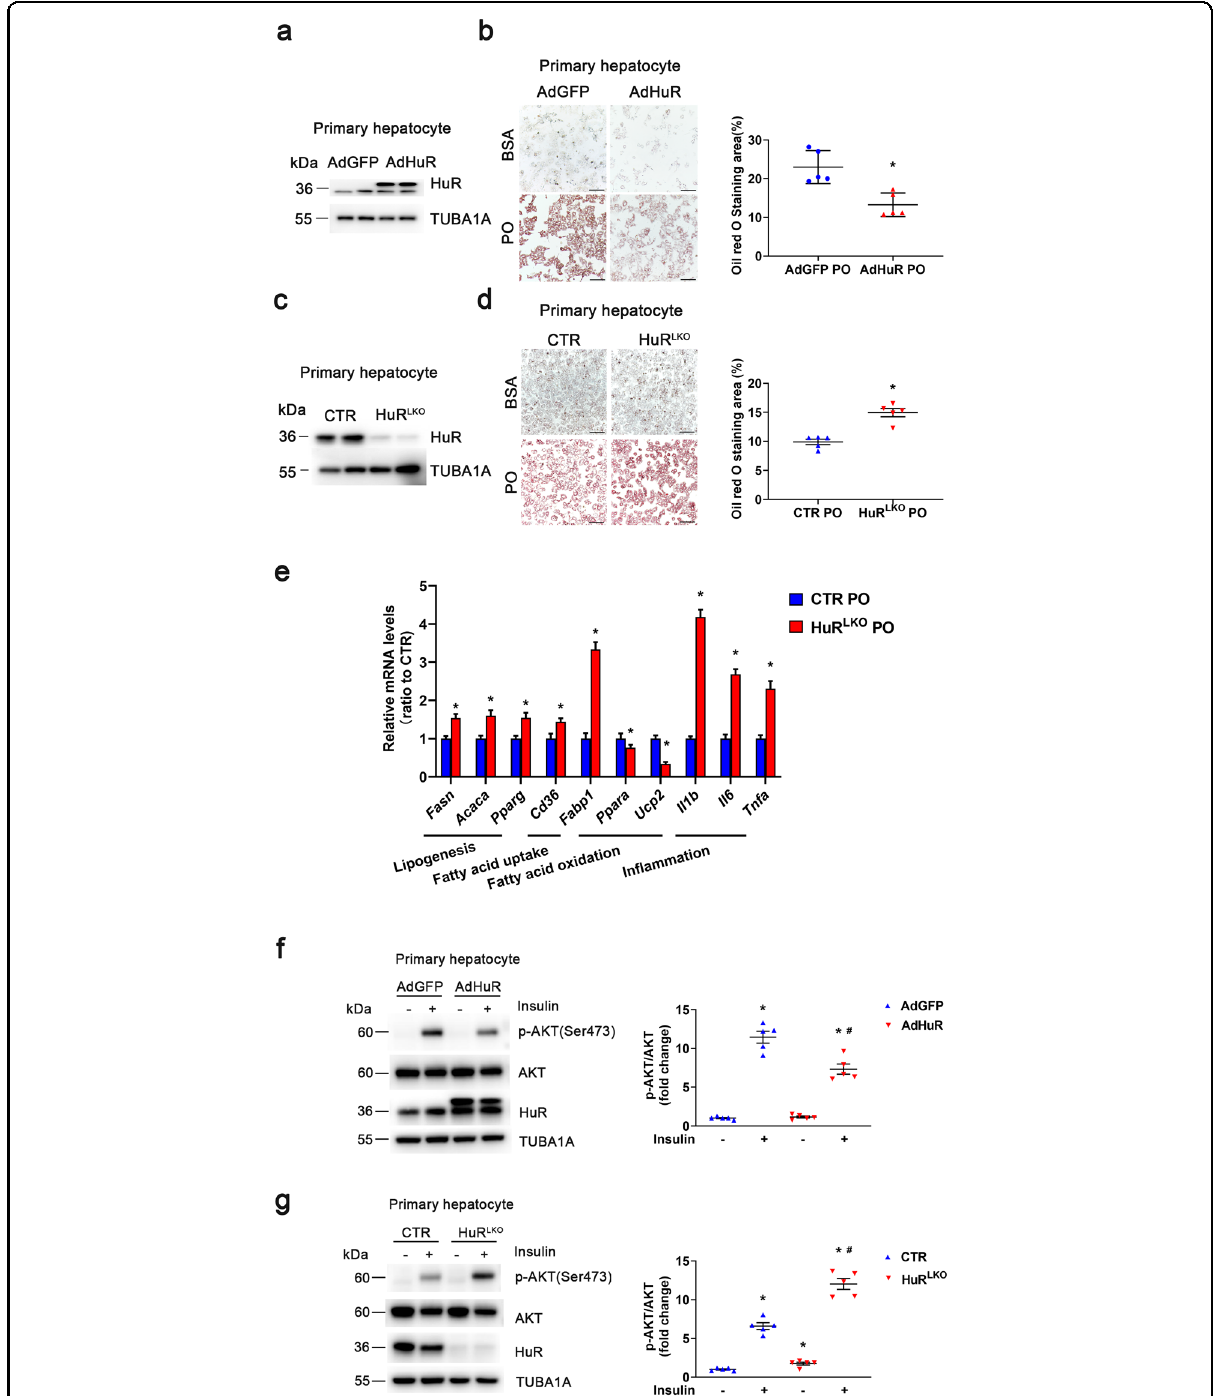
Fig. 4 HuR inhibited lipid accumulation in hepatocytes. a Western blot analysis of HuR protein expression of primary hepatocytes infected with adenovirus expressing GFP or HuR for 24 h. b After infection with adenovirus for 24 h, primary hepatocytes were treated with BSA or PO for 24 h, followed by Oil-red O staining ( n = 5). Scale bar, 50 μ m. * P < 0.05 vs AdGFP PO. c Western blot analysis of HuR protein levels in primary hepatocytes from HuR LKO and CTR mice. d Primary hepatocytes were treated with BSA or PO for 24 h, followed by Oil-red O staining ( n = 5). Scale bar, 100 μ m. * P < 0.05 vs CTR PO. e Relative mRNA expression of the indicated molecules in primary hepatocytes treated with PO ( n = 5). * P < 0.05 vs CTR PO. f Western blot analysis of AKT phosphorylation in primary hepatocytes (from CTR mice) infected with AdGFP or AdHuR; the hepatocytes were then stimulated with insulin (10 µM) for 8 min ( n = 5). * P < 0.05 vs AdGFP saline, # P < 0.05 vs AdGFP insulin. g Western blot analysis of AKT phosphorylation in primary hepatocytes of CTR and HuR LKO mice stimulated with insulin (10 µM) for 8 min ( n = 5). * P < 0.05 vs CTR saline, # P < 0.05 vs CTR